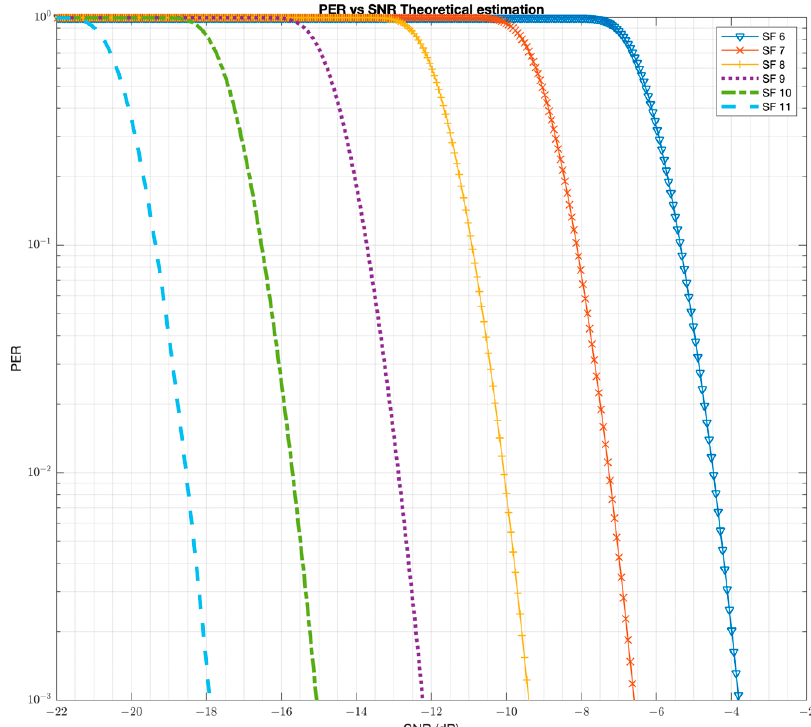
Figure 4. The PER estimate with the LoRa modulation with 64 bytes payload .